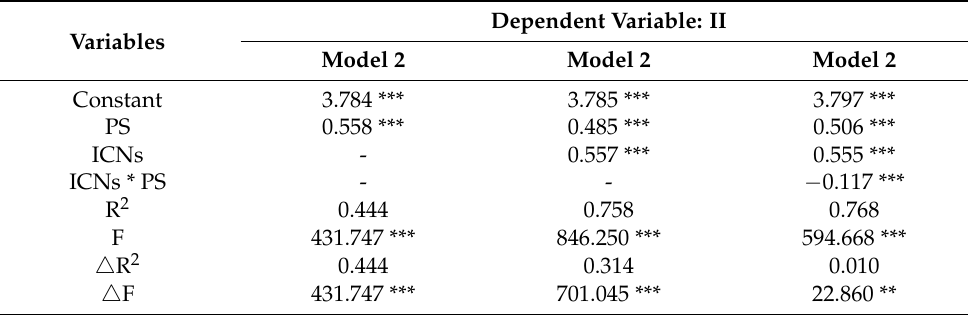
Table 9. Hierarchical regression analysis of relationship between ICNs, PS, and II. Dependent Variable: II Variables Model 2 Model 2 Model 2 Constant 3.784 *** 3.785 *** PS 0.558 *** 0.506 *** ICNs - 0.557 *** 0.555 *** ICNs * PS -